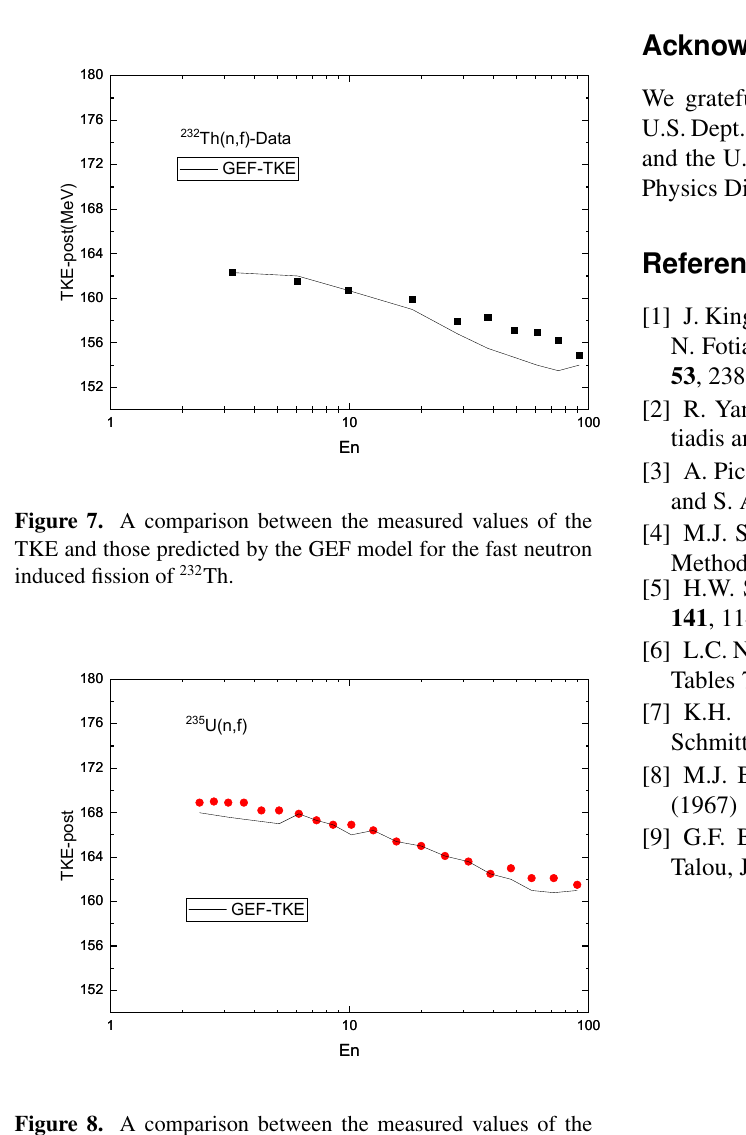
Figure 8. A comparison between the measured values of the TKE and those predicted by the GEF model for the fast neutron induced fission of 235 U.